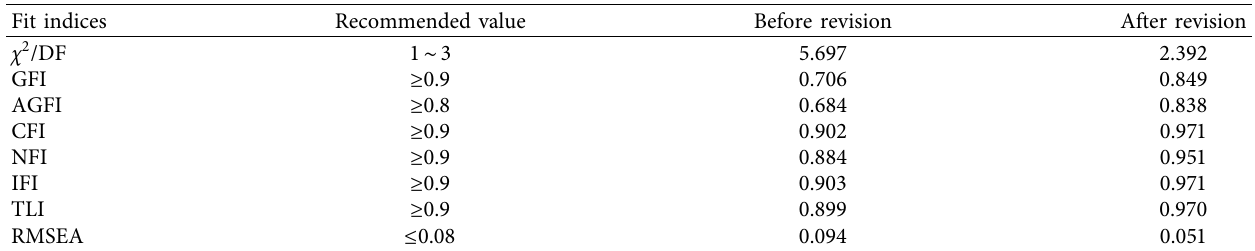
Table 7: Comparison of the goodness-of-fit values between the hypothetical model and the modified model.